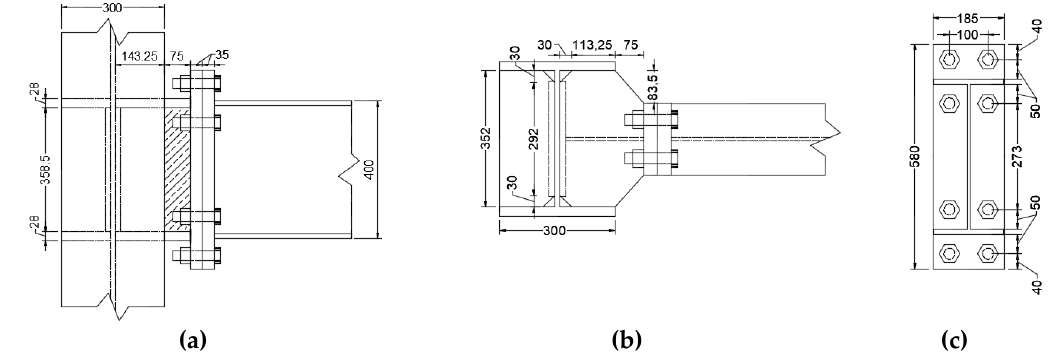
Figure 1. View of a weak-axis moment connection.